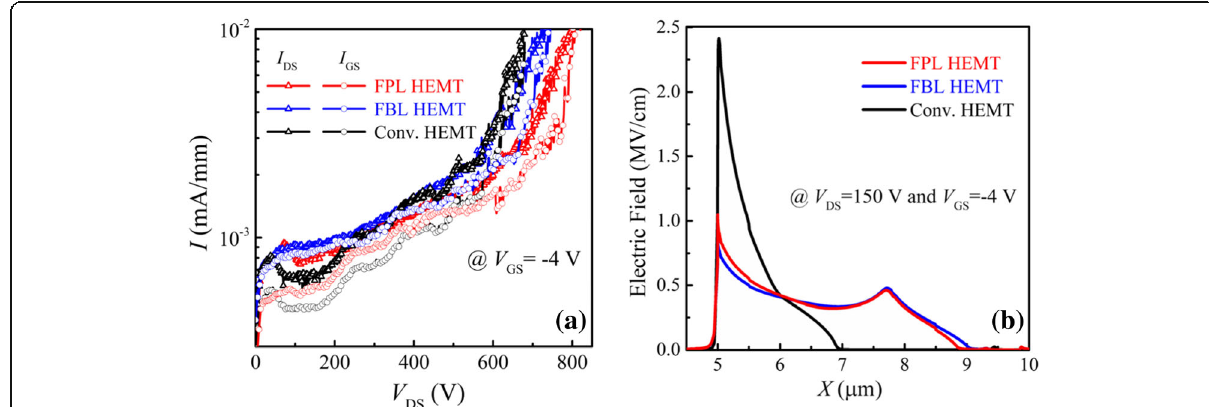
Fig. 4 a Measured off-state I-V characteristics with a gate voltage of − 4 V, keeping the substrate floated. b Simulated surface E-field distributions at V DS = 150 V